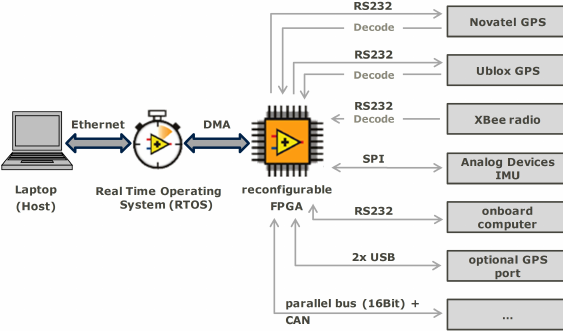
Figure 3: The data links of the direct georeferencing system. munication between the FPGA and the RTOS processor occurs by a direct memory access (DMA). Thus, the preprocessed data of the sensors is directly written into the main memory, without detours using the processors. In this way running processes will not be disturbed during data transfers, which is very important for real-time processing.